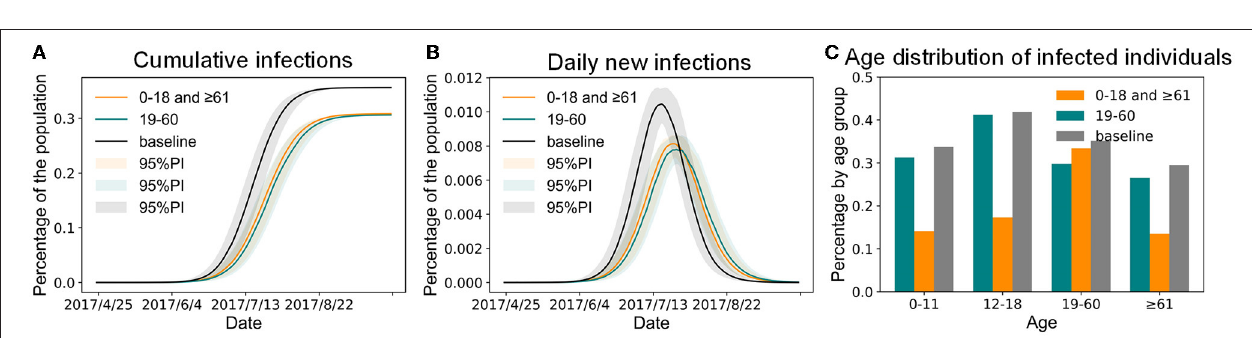
FIGURE 6 | The impact of vaccinating the same population size in different age groups of Shenzhen. (A) Cumulative infections. (B) Daily new infections. (C) Age distribution of infected